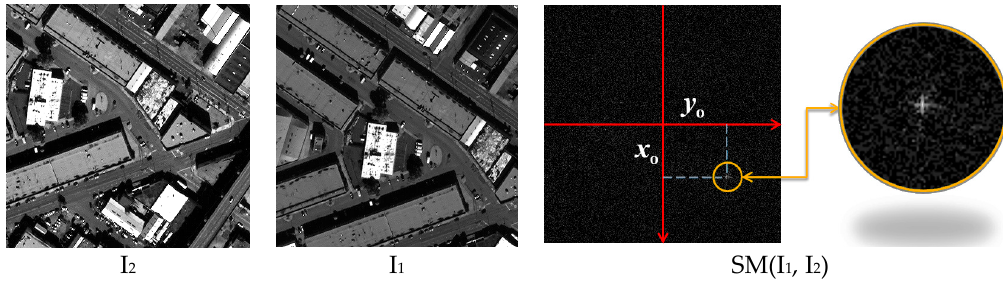
( b ) Figure 10. The shadow map extracted from the raster LiDAR data for the sample dataset: ( a ) Result